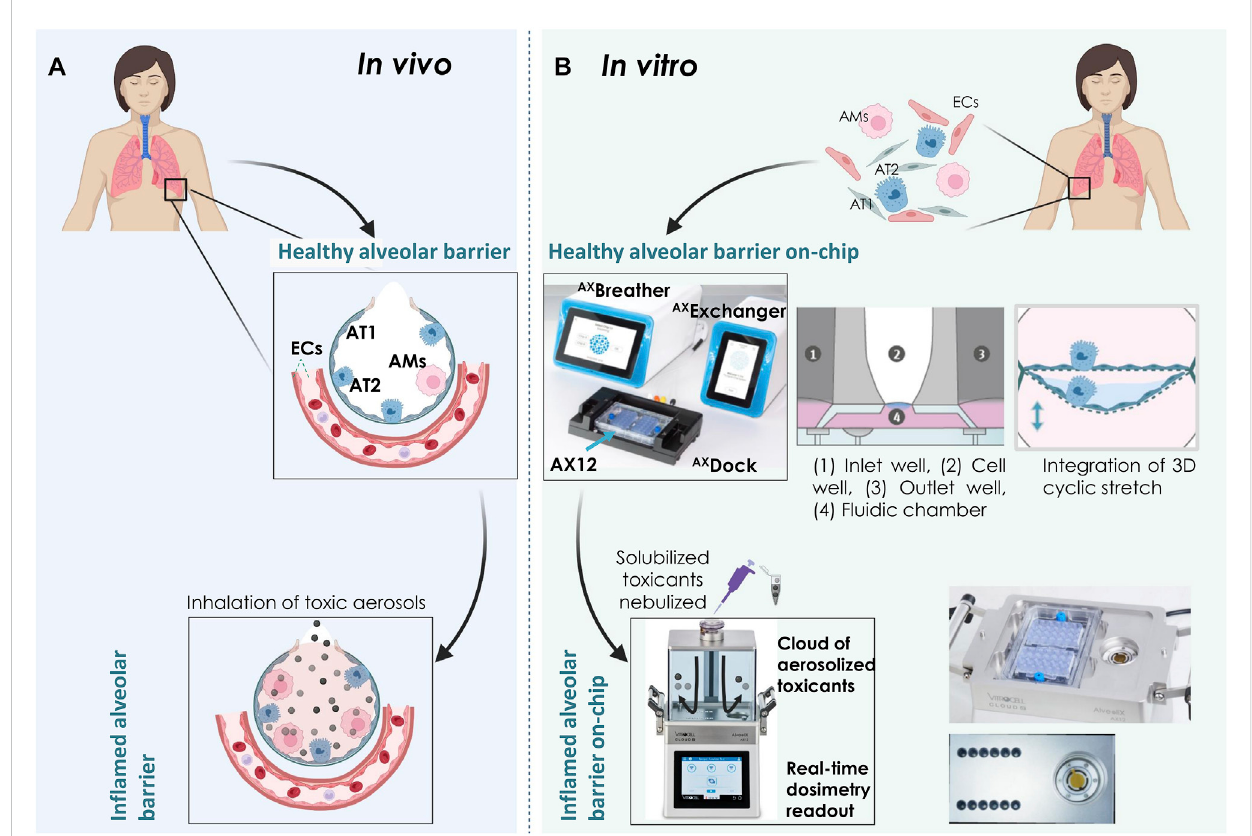
FIGURE 1 Overview of the Cloud α AX12 platform (A) An illustration showing the alveolar barrier in situ . The alveolar epithelial cells are situated on a thin basement membrane and are in close contact with the endothelial cells (ECs) on the basal side. The alveolar epithelium is comprised of squamous and thinalveolartype1(AT1)andcuboidalalveolartype2(AT2)cellsalongwithresidentalveolarmacrophages(AMs).Inhaledtoxicparticlesarerepresentedas black and grey spheres. Inhalation of such airborne toxic particles result in lung in fl ammation, toxicity and progression to COPD. (B) Schematic representation of the AX Lung-on-chip (including AX Breather, AX Exchanger, AX Dock platform and the lung-on-chip consumable AX12) and Cloud α AX12 platform to model healthy and in fl amed alveolar barrier in vitro . Primary and immortalized cells isolated from human sources were used in the model. In fl ammation on-chip was mimicked using nebulized compounds with the Cloud α AX12. Created with